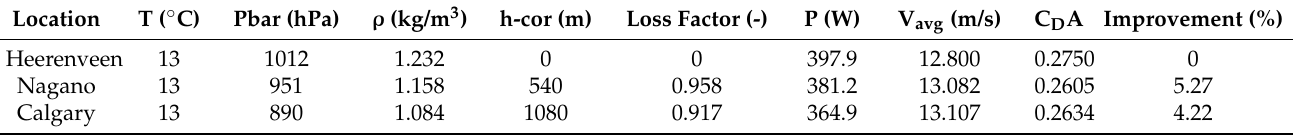
Table 4. The calculated drag area of Gianni Romme in Nagano and Calgary with his estimated power available at altitude, using a power loss factor of 0.923 per 1000 m elevation. Local barometric pressures were used; h-cor is the corrected elevation according to the ISA